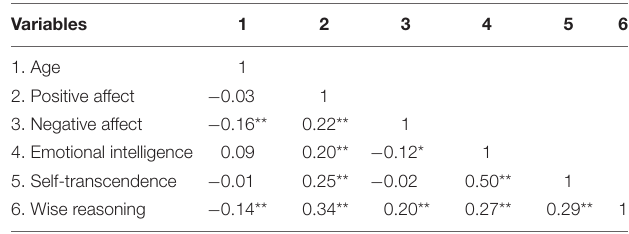
TABLE 1 | Correlation matrix of age and other variables ( N =